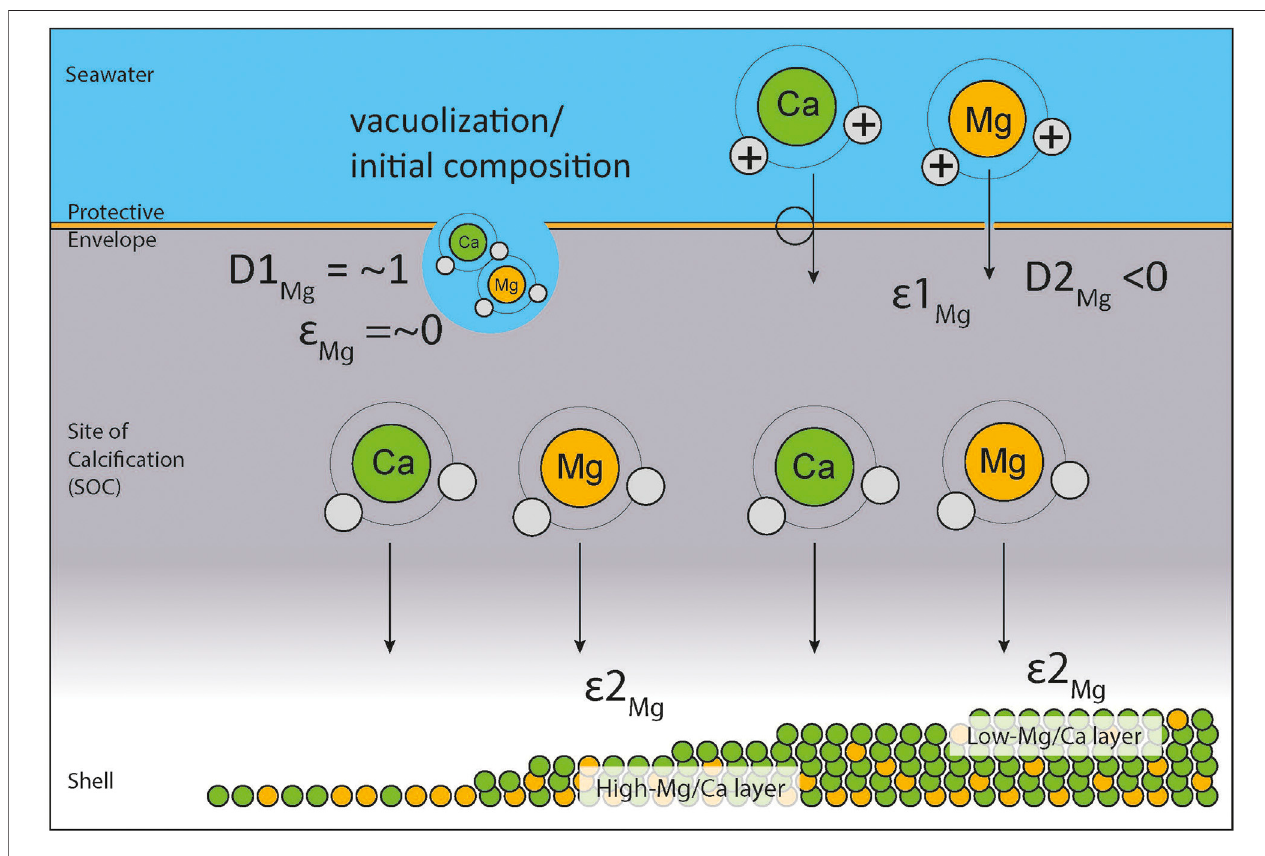
FIGURE 5 | Summary of Mg fractionation during hyaline foraminiferal calci fi cation.